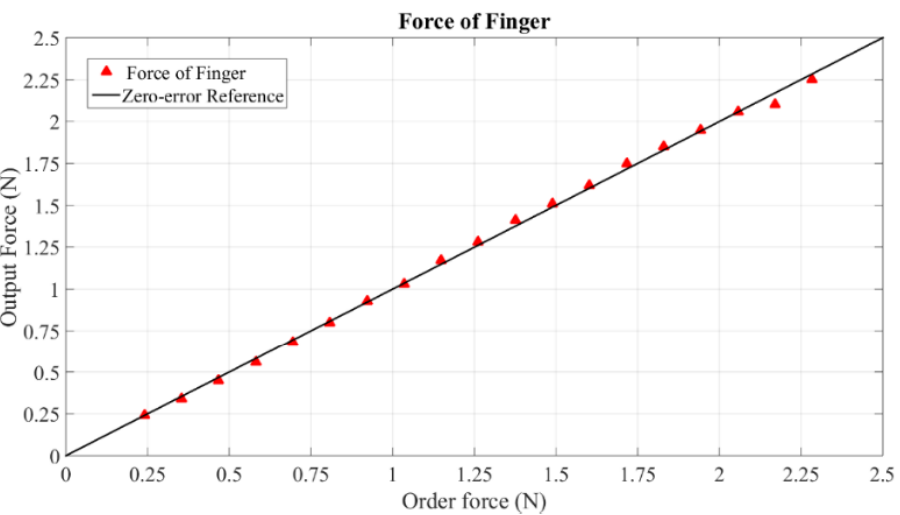
Figure 21. Torque in pitch. Sensors 2015 , 15 , page–page